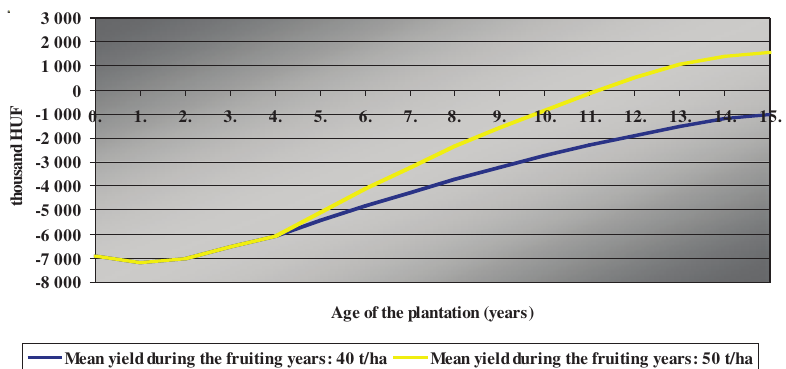
Figure 2. Economy and returns of plantations equipped with hail protecting nets without subsidy given for investment (net incomes on the present value are accumulated (NPV) expressed in thousand